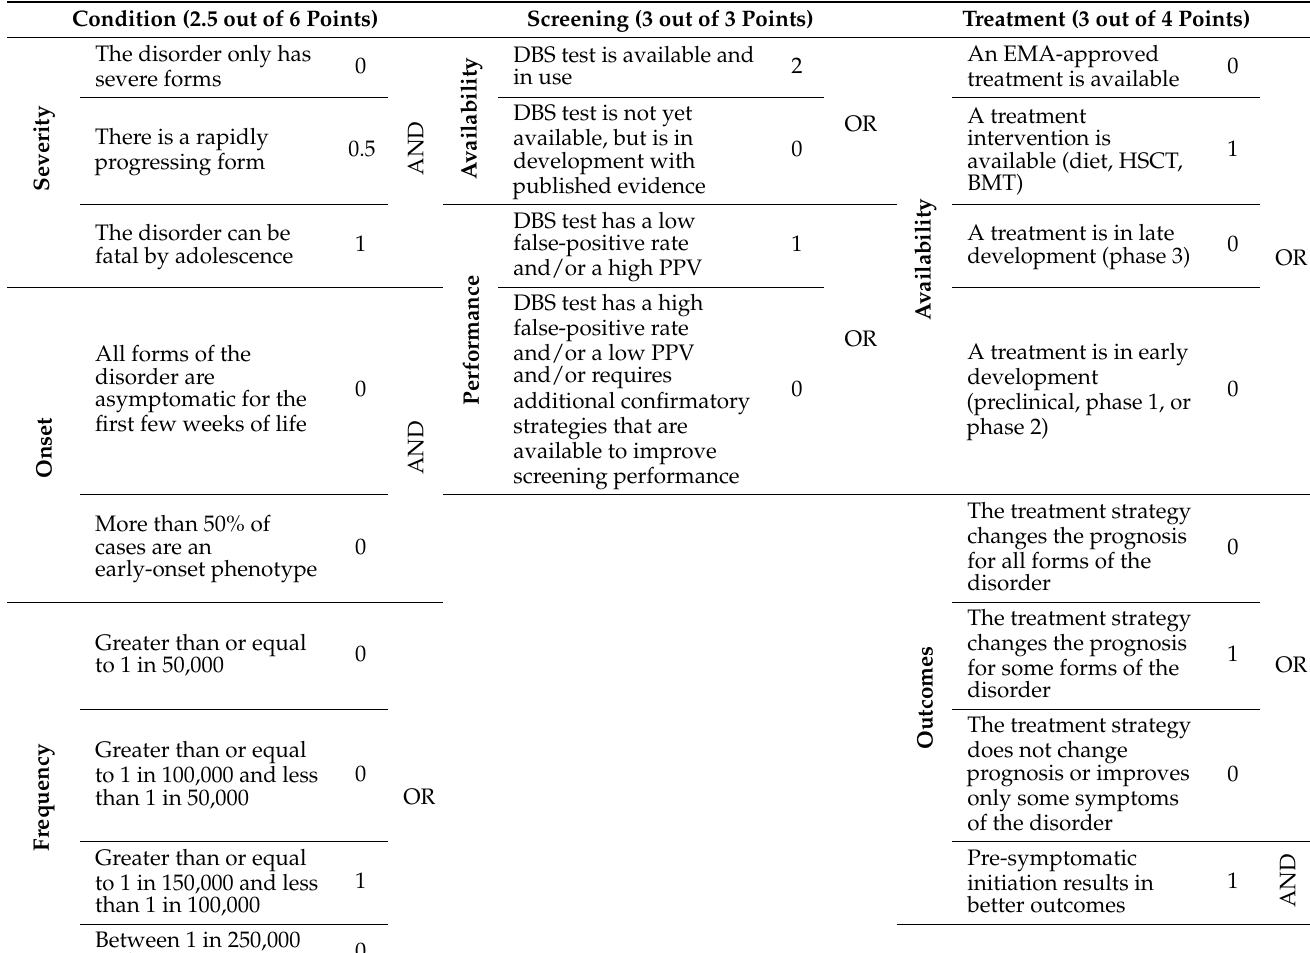
Table A5. Isovaleric acidaemia (IVA), 8.5